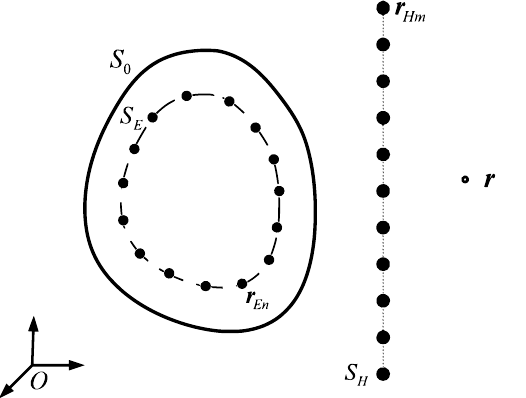
Figure 1. The schematic diagram of the ESM. S 0 is the surface of the vibrating object, S E is the virtual surface of the equivalent source, and S H is the measuring surface. r Hm is the m th measuring position on the S H , r En is the n th equivalent source on the S E , and r is a point in the source-free